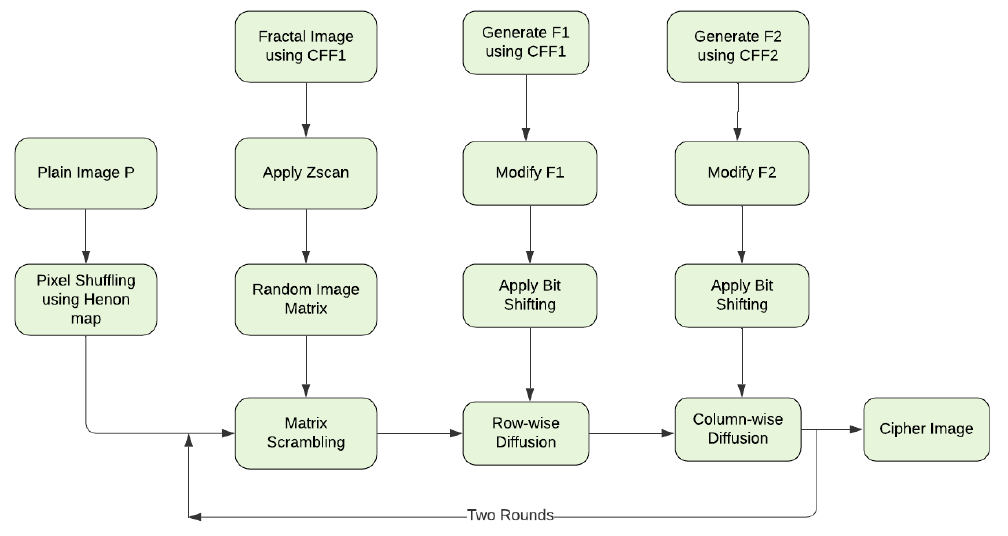
Figure 6. Proposed Image encryption method block diagram.